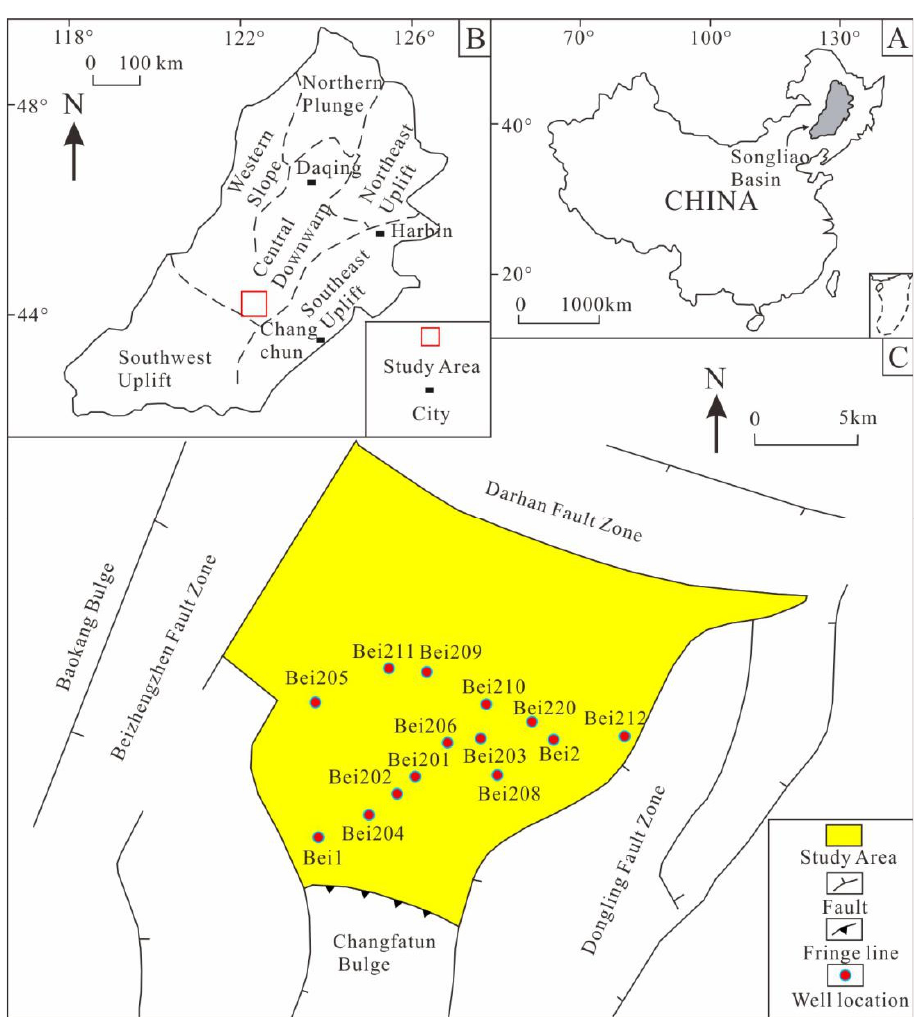
Figure 1. Geographical location of the Longfengshan subsag. ( A ) Location of the Songliao Basin. ( B ) Location of the Longfengshan subsag in the Songliao Basin. ( C ) Well location distribution in the Longfengshan